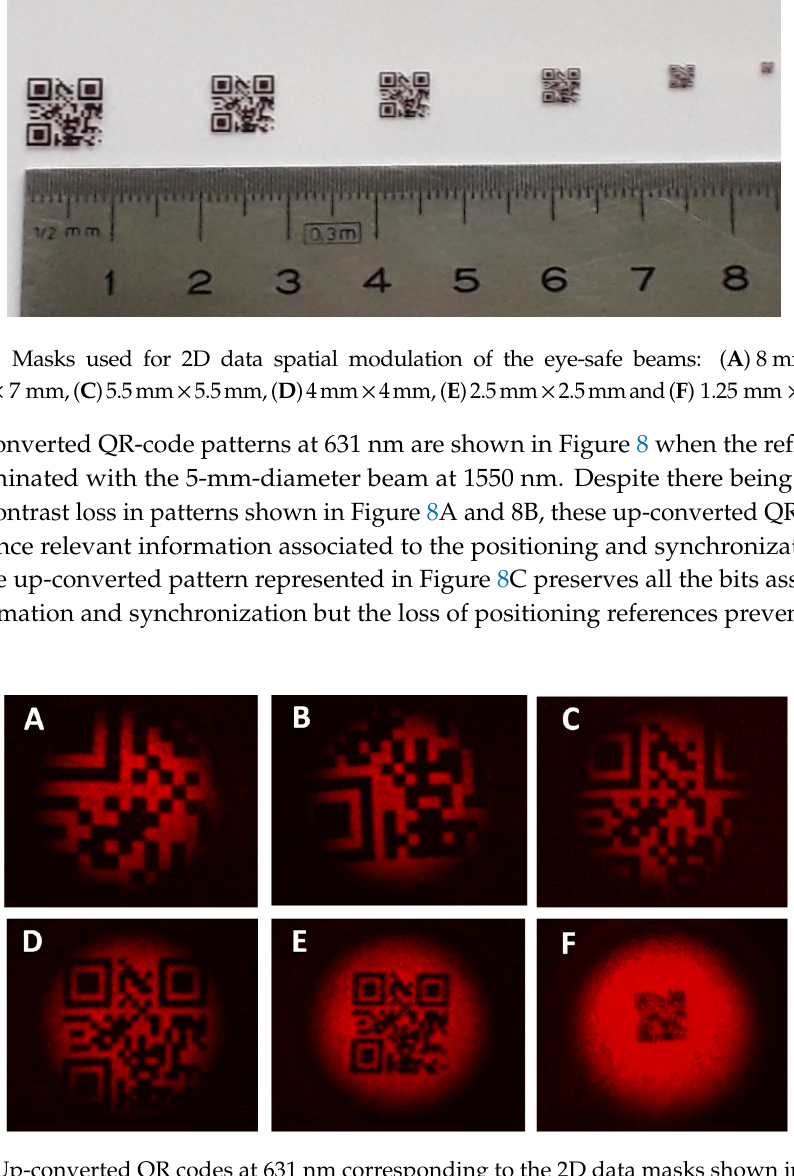
Figure 8. Up ‐ converted QR codes at 631 nm corresponding to the 2D data masks shown in Figure 7: ( A ) 8 mm × 8 mm, ( B ) 7 mm × 7 mm, ( C ) 5.5 mm × 5.5 mm, ( D ) 4 mm × 4 mm, ( E ) 2.5 mm × 2.5 mm and ( F ) 1.25 mm × 1.25 mm.